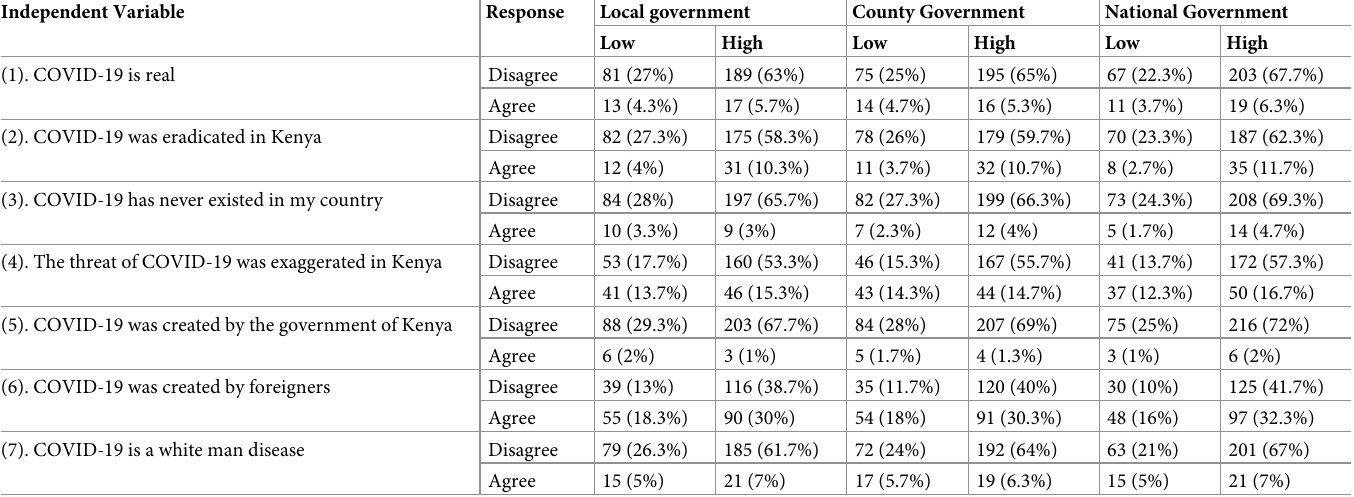
Table 2. COVID-19 conspiracy theories among self-confirmed CHVs n = 300 (frequencies). Independent